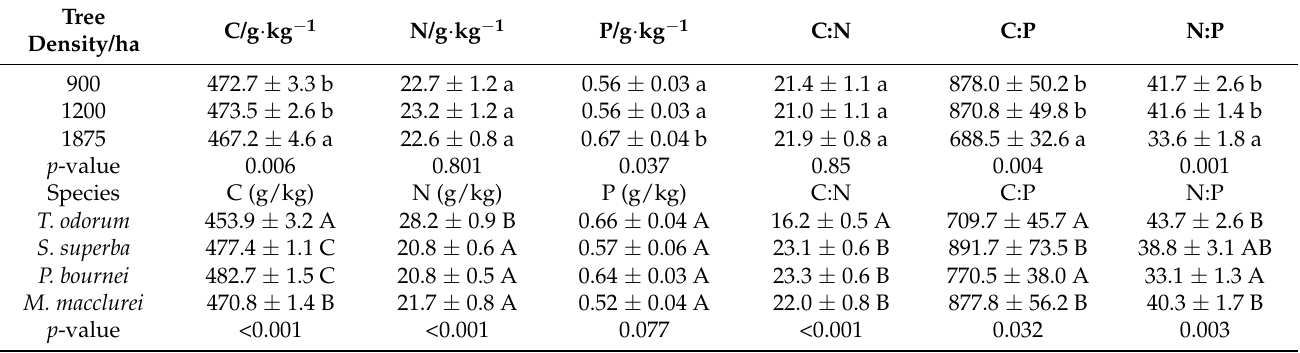
Table 4. C, N and P contents of four broad-leaved tree species underplanted in Chinese fir planta- tions with different tree density (Mean ± SE). Means followed by different lower case letters are different among tree density levels and those followed by upper case letters are significantly different among